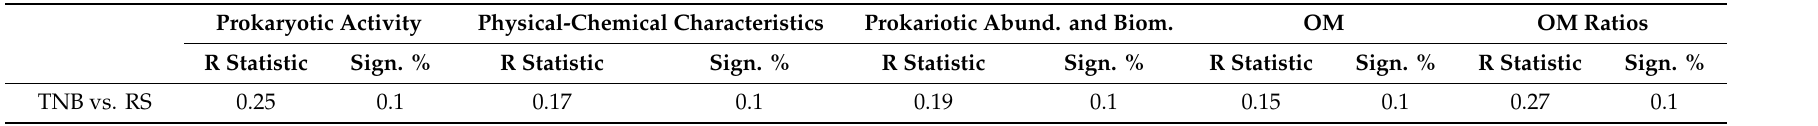
Table 4. Results for the ANOSIM applied on the normalized and resembled (Euclidean distances) data for the macro-areas TNB and RS. Prokaryotic Activity Physical-Chemical Characteristics Prokariotic Abund. and Biom. OM OM Ratios R Statistic Sign. % R Statistic Sign. % R Statistic Sign. % R Statistic Sign. % R Statistic Sign. % TNB vs. RS Table 5. Results for the ANOSIM applied on the normalized and resembled (Euclidean distances) data for each sub-area. Physical-Chemical Prokariotic Abund. Prokaryotic Activity OM OM Ratios Characteristics and Biom. R Statistic Sign. % Sign. % R Statistic Sign. % R Statistic Sign. % R Statistic Sign. % global test